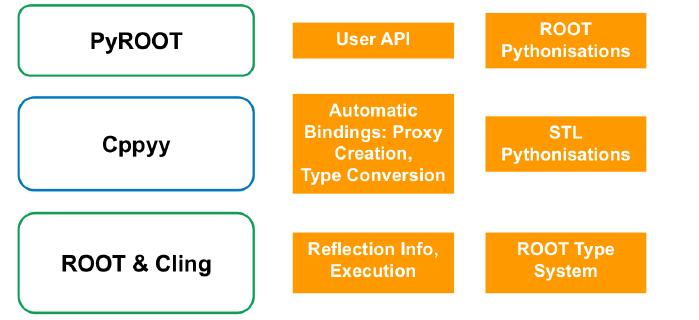
Figure 1: Design of the new PyROOT on top of cppyy.